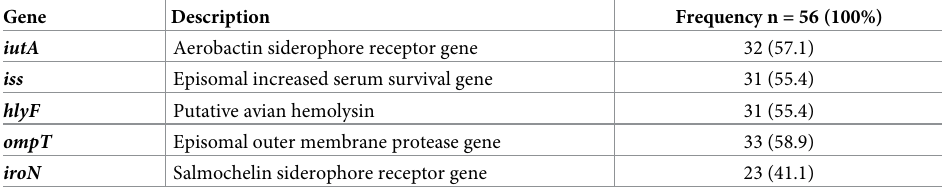
Table 2. Frequency of the selected virulence genes among the APEC suspect isolates.